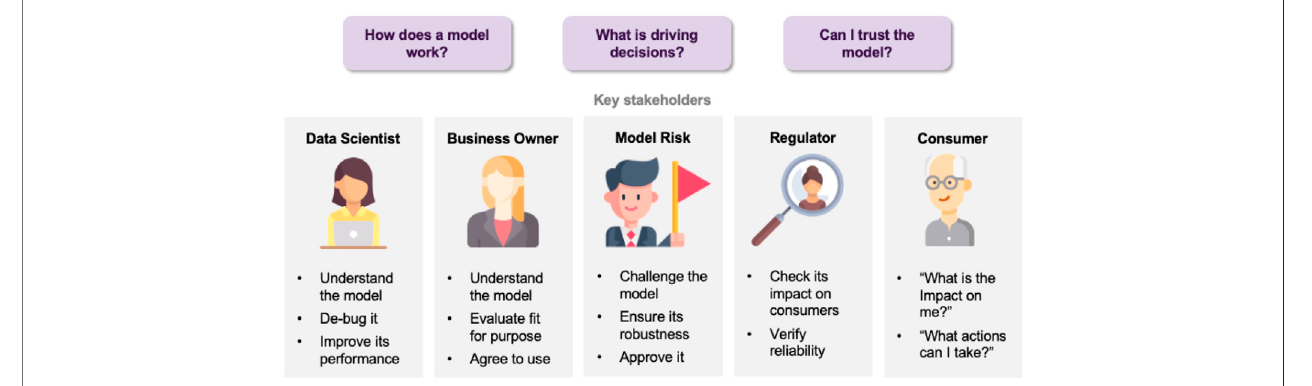
FIGURE 1 | Concerns faced by various